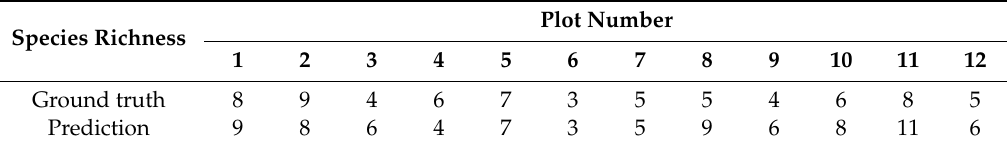
Table 4. The field-surveyed and predicted tree species richness. Species